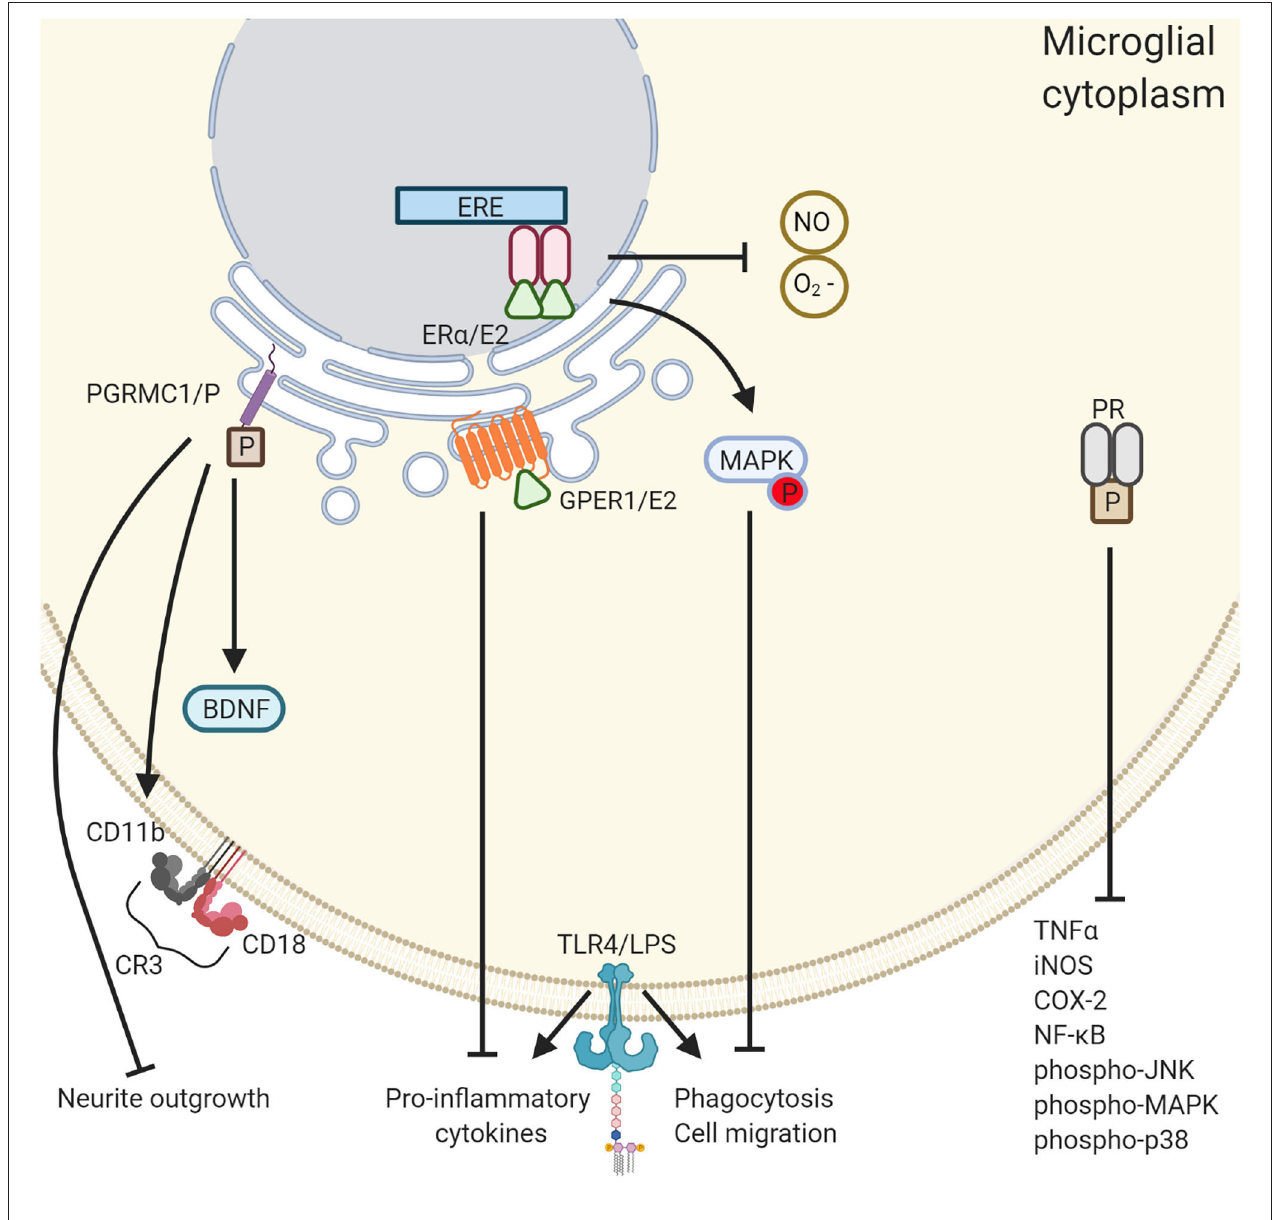
FIGURE 2 | The differential roles of ovarian hormones in the microglial immune response. PGRMC1 activation induces microglial activation whereas PR and E2 quiesces it. PGRMC1 binds to progesterone leading to the inhibition of neurite outgrowth, microglia activation through the expression of CD11b and CD18, and the inhibition of BDNF. Conversely, GPER1 activation by E2 reduced the expression of proinflammatory cytokines TNF- α and IL-1 β . In addition, E2 reduces microglial phagocytosis and cell migration through activation of the MAPK pathway and inhibits the release of reactive oxygen species NO and O2 − . PR activation also has an anti- inflammatory effect through the inhibition of a various of inflammatory cytokines. Created with